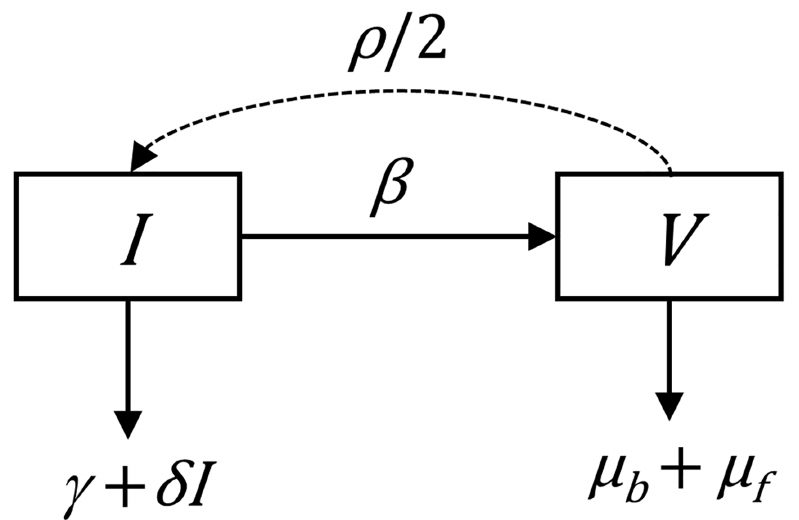
Fig 1. Ordinary differential equation model of tsetse population dynamics. Pupae, I , metamorphoseinto adults, V at rate β . We take ρ as the rate of productionof pupaeby adult females. Only half of the emerging flies are female, so female pupaeare produced at rate ρ /2. Adult losses are due to background mortality at rate μ b and starvation mortality at rate μ f , both considered density independent.Pupal losses are divided betweendensity-independentmortality γ , and density-dependentmortality with coefficient δ . All rates have units days -1